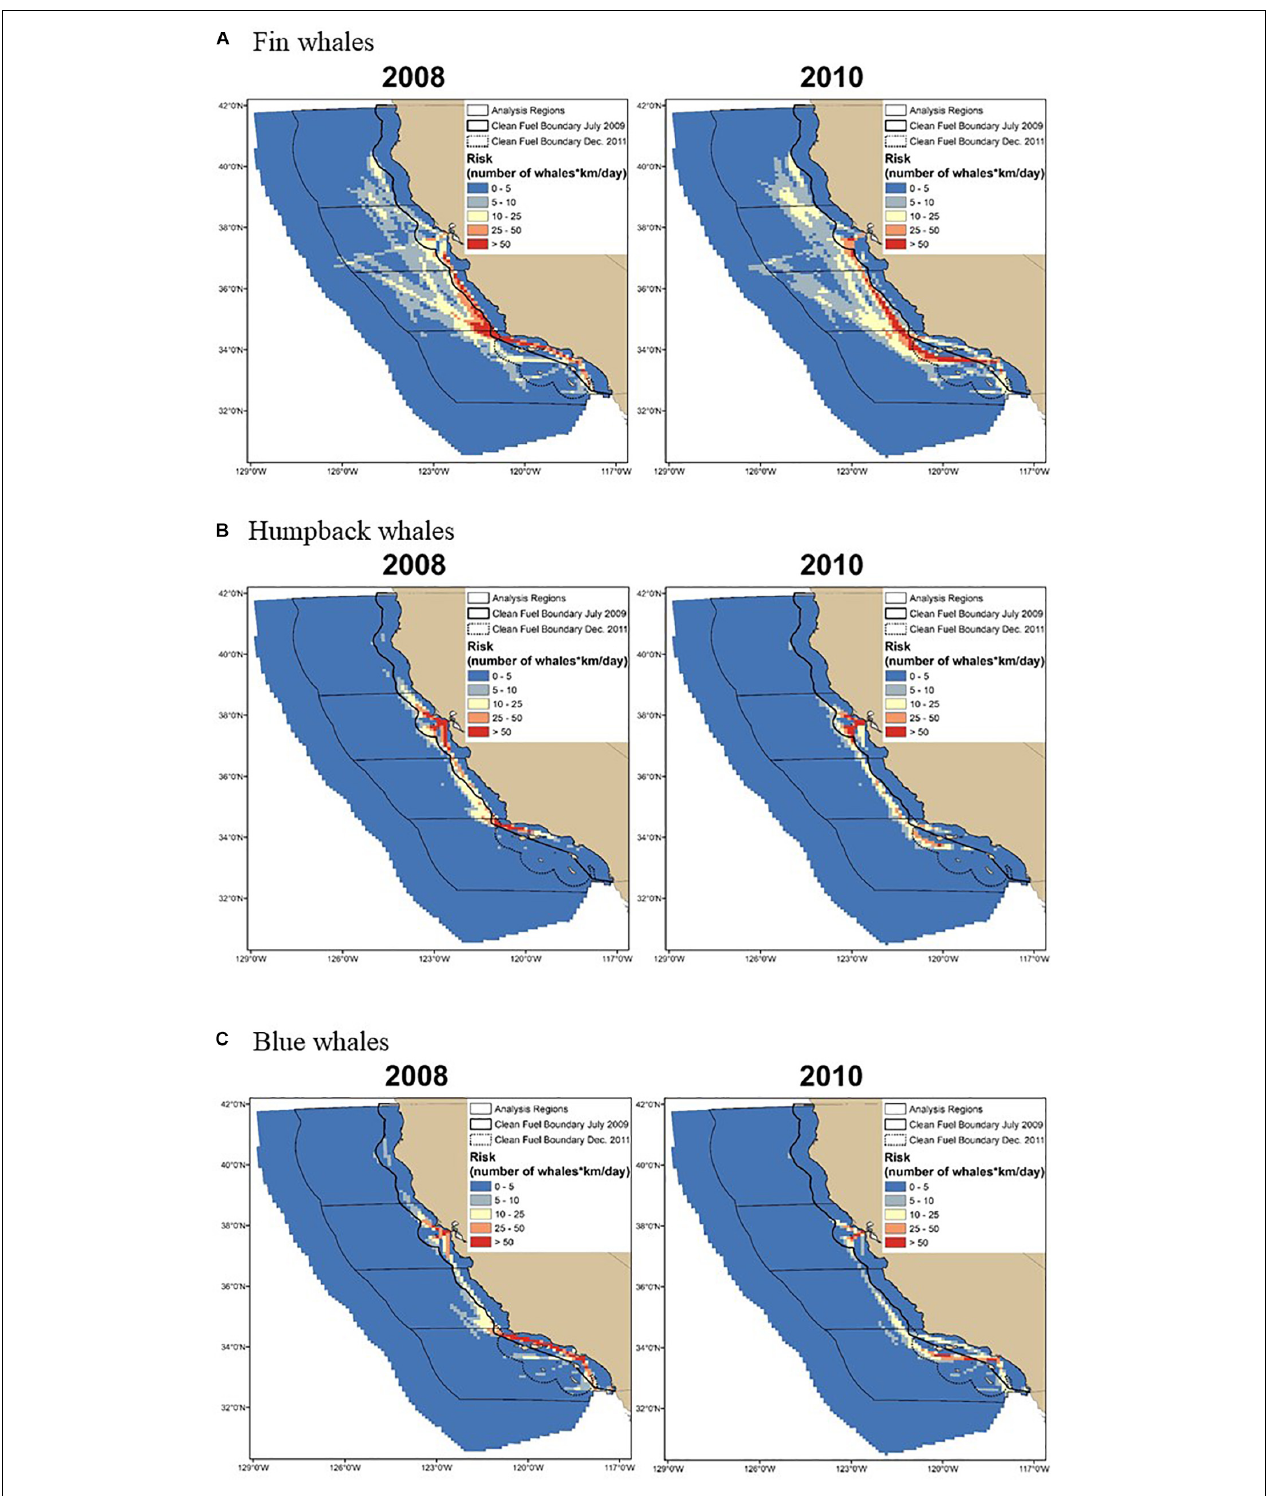
FIGURE 4 | Ship-strike risk for (A) fin, (B) humpback, and (C) blue whales calculated using mean predicted whale distributions is shown for a year with nearshore (2008) and offshore (2010) traffic. Ship-strike risk was defined as the predicted number of whales multiplied by the km/day traveled by ships, which is a measure of co-occurrence. Consequently, the numbers used to define the break points in the maps provide a relative measure of increasing risk. The same break points were used for all species and years to allow for comparisons among maps. The percentage of ships traveling more than 24 nmi from the mainland coast (i.e., the 2009 clean fuel boundary) was used to define nearshore versus offshore traffic (see text for